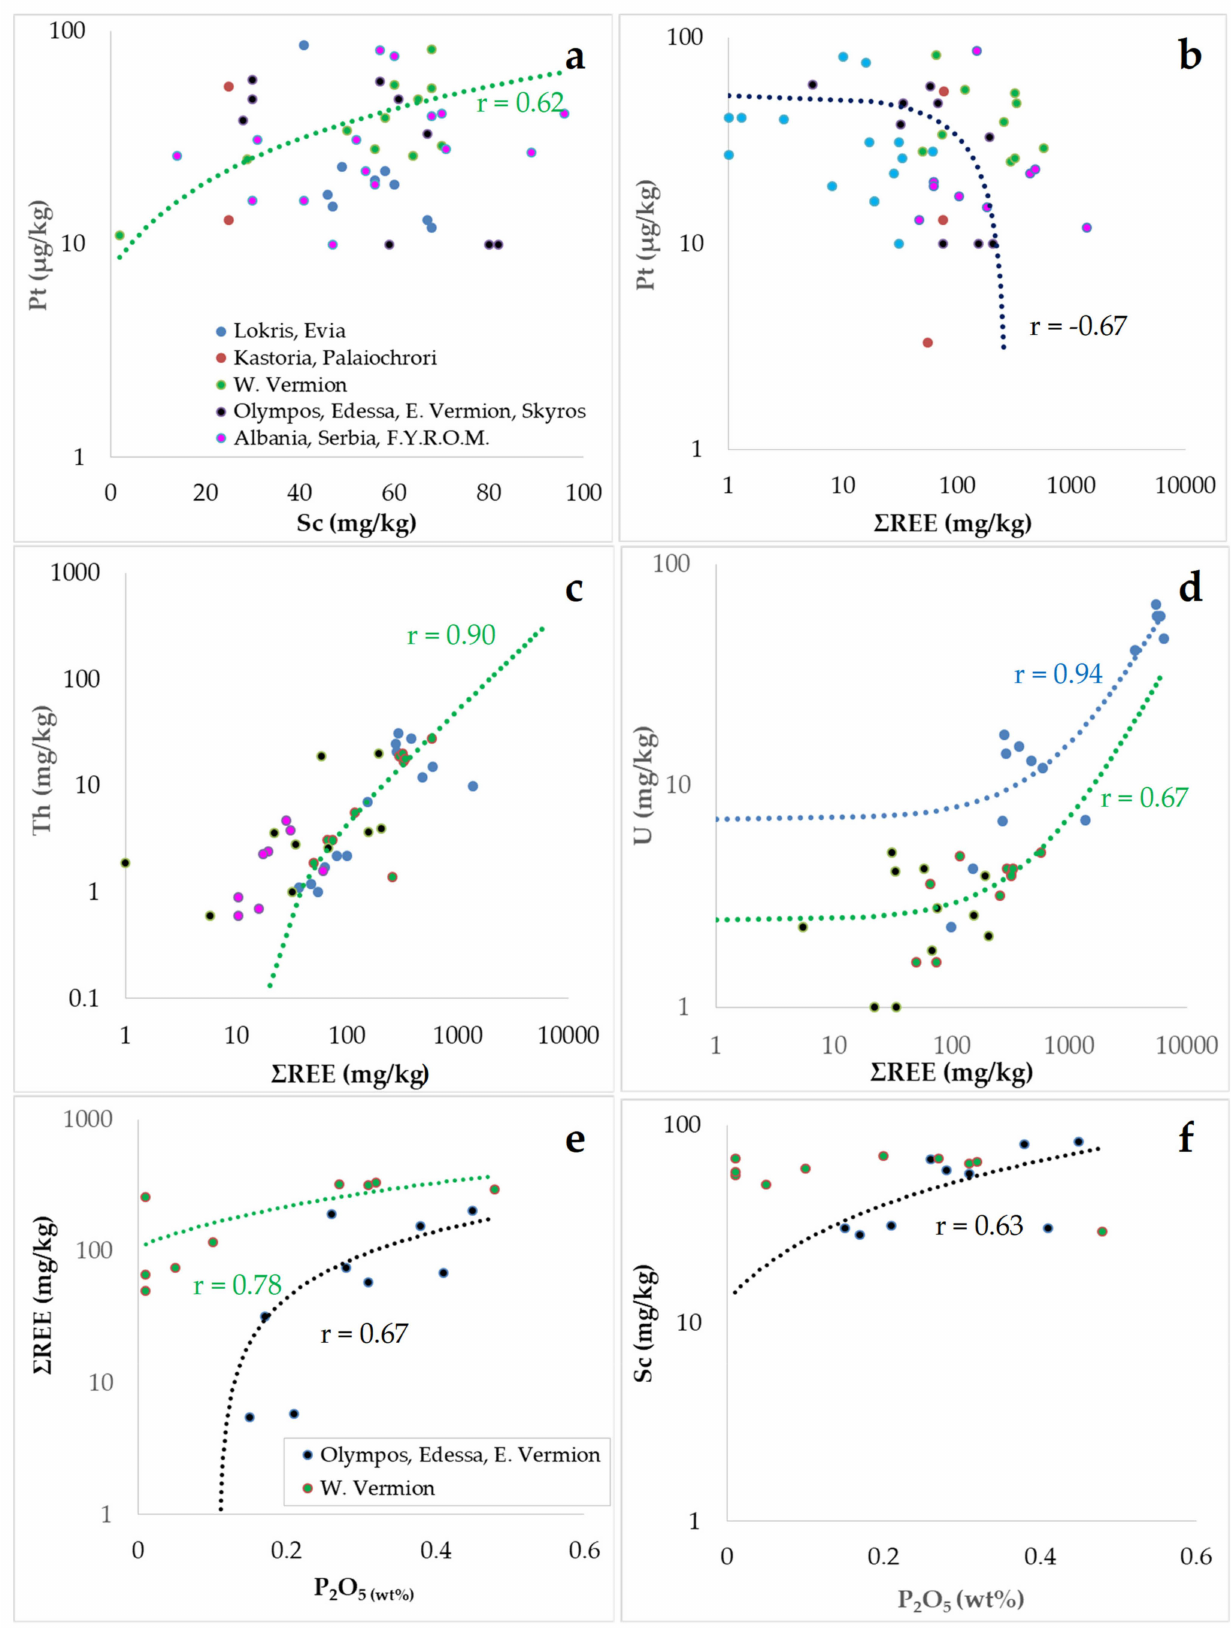
Figure 12. Plots of Pt versus Sc and Σ REE ( a , b ); Th and U versus Σ REE ( c , d ), and Σ REE, Sc versus P 2 O 5 ( e , f ). Data from Tables